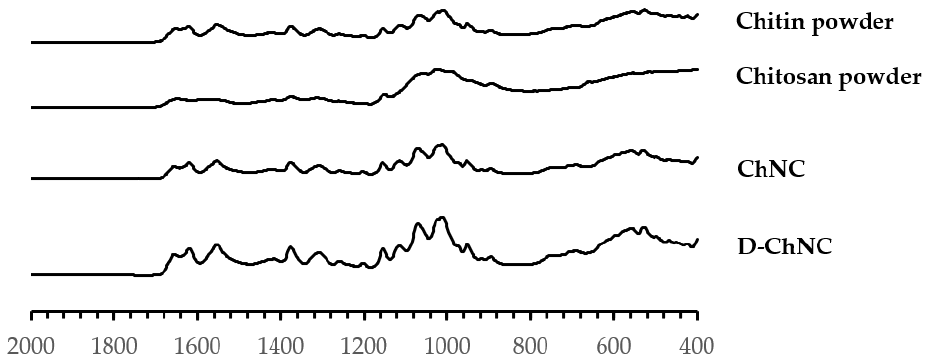
Figure A4. FTIR spectra for chitin powder, chitosan powder, chitin nanocrystals (ChNC) and deacety-